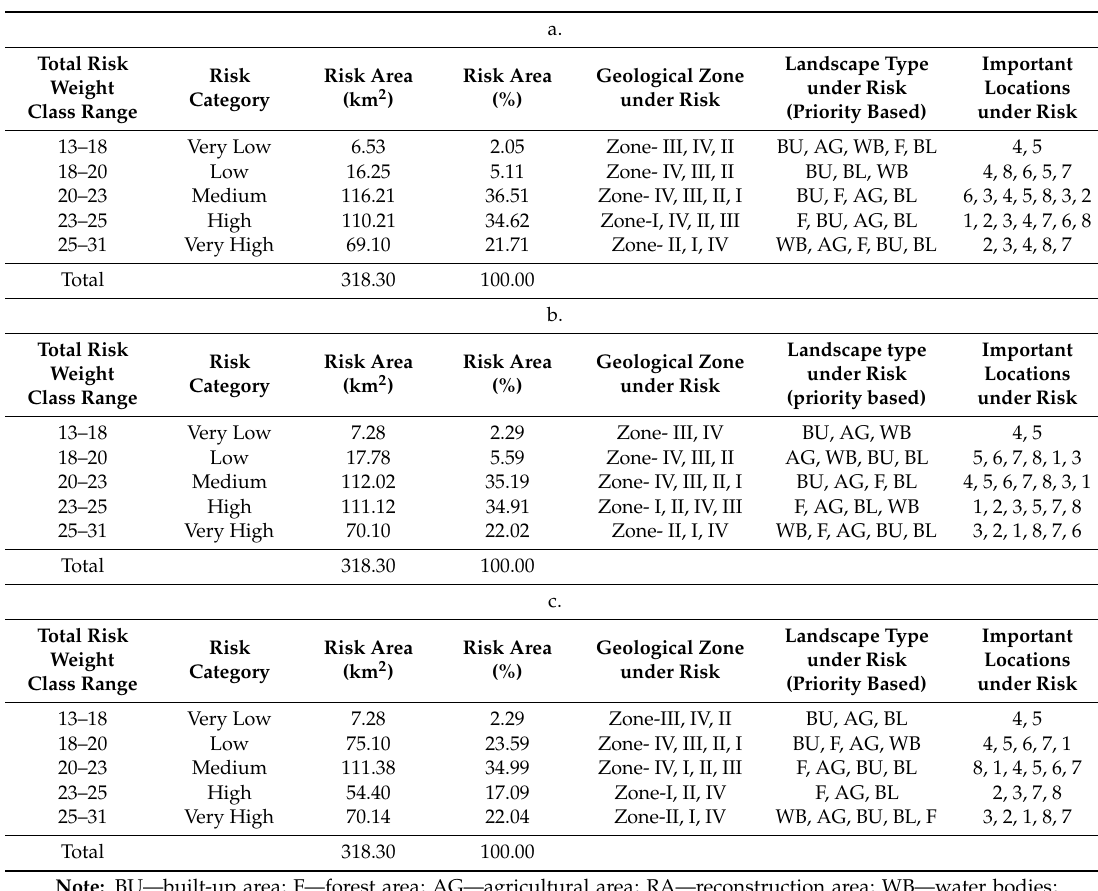
Table 9. FPLR identification and pattern of change analysis based on integrated datasets in di ff